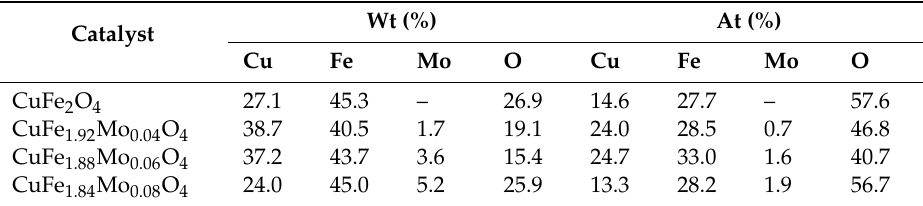
Table 1. Chemical composition of copper ferrites substituted with molybdenum.